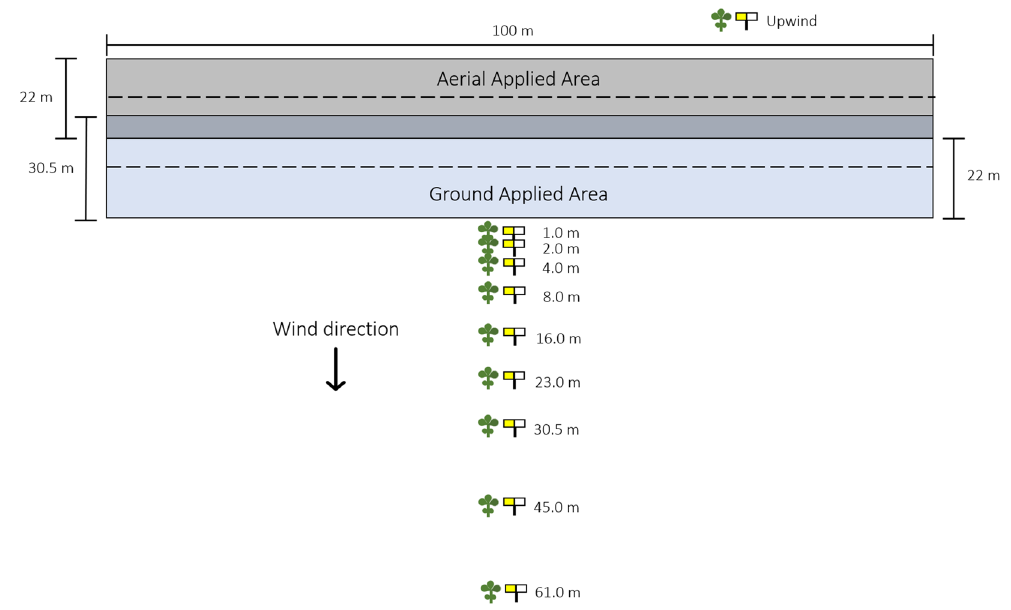
Figure 3. Diagram of the spray drift field experiment setup including the intended applied area of each application method (black = aerial, blue = ground) and the 10 collection station locations (nine downwind, one upwind).